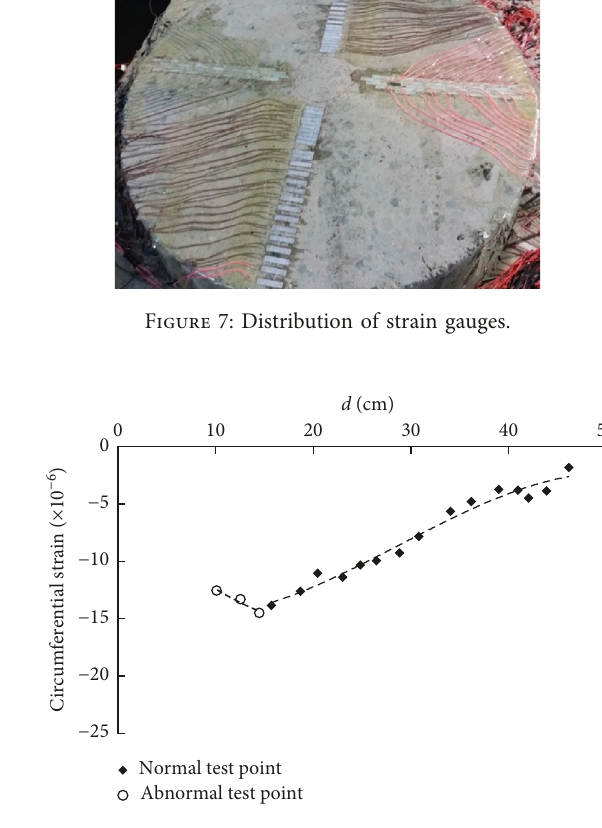
Figure 8: The test result of circumferential strain on the top of the CSM pavement structure